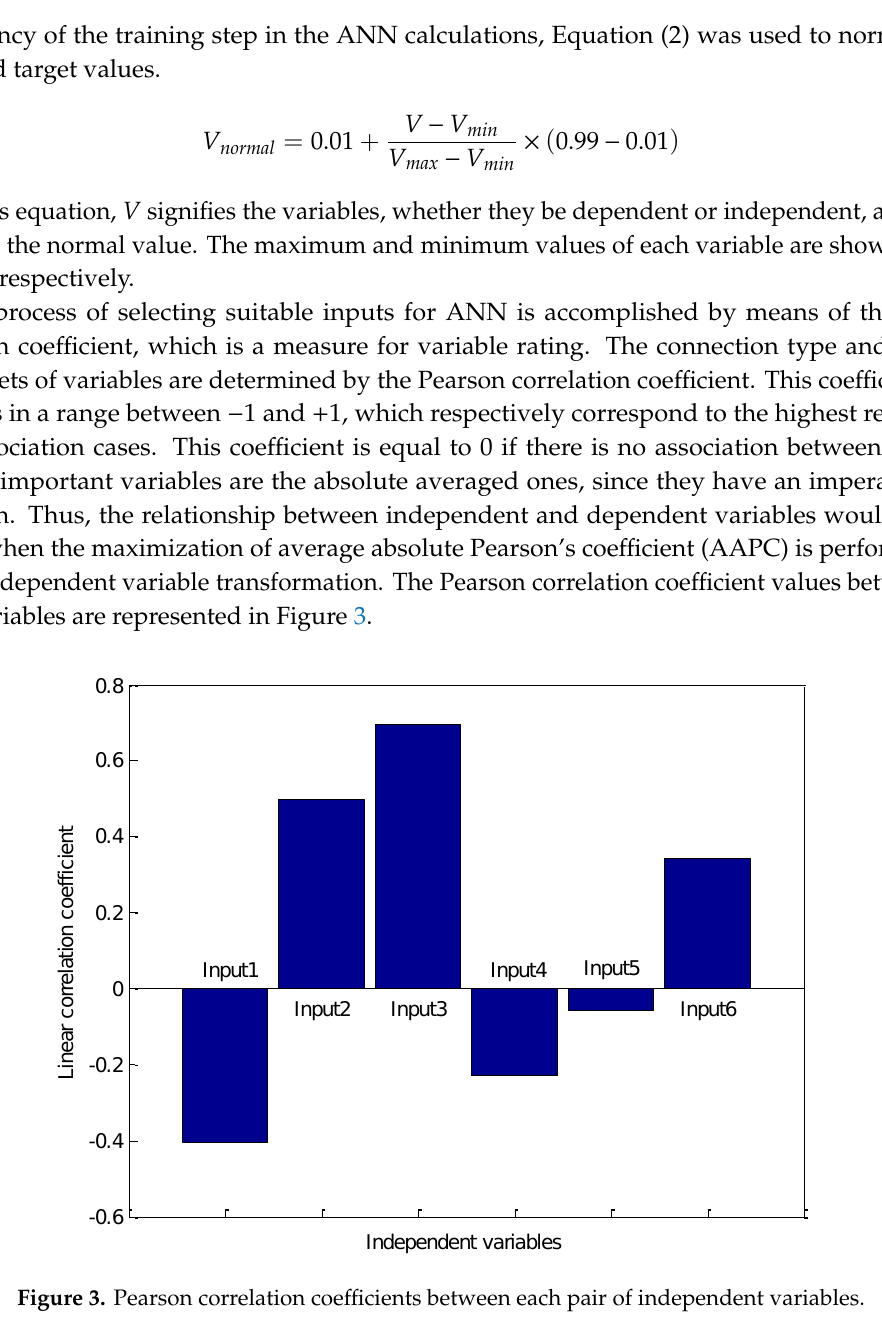
Table 3. Pearson’s coefficient values for different transformations.